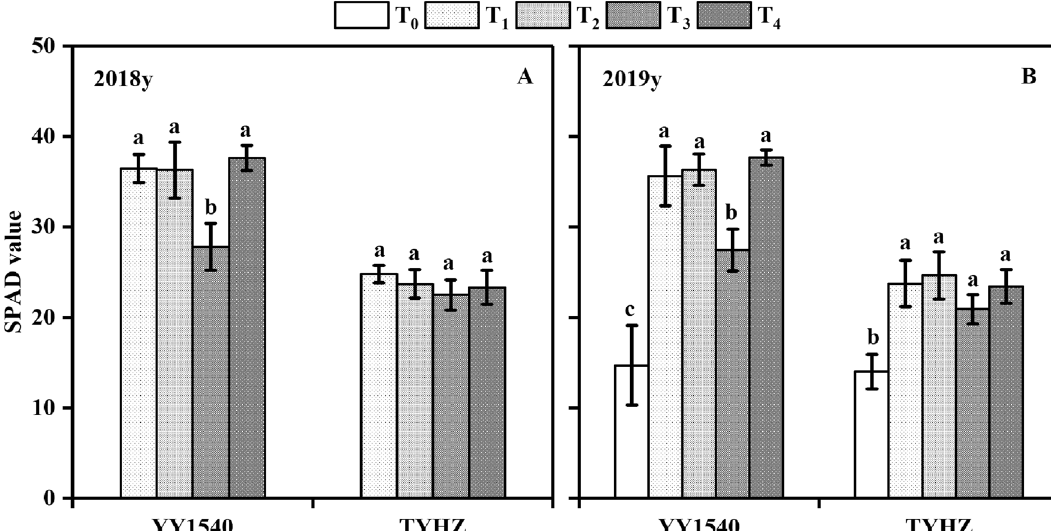
Figure 4. SAPD value at maturing stage of indica – japonica hybrid rice (‘Yongyou1540 ′ , YY1540) and indica hybrid rice (‘Tianyouhuazhan’, TYHZ) under four nitrogen fertilization treatments. ( A ) 2018; ( B ) 2019. Bars with different lower-case are significantly different at the 0.05 probability level among treatments. T 0 no-nitrogen application control, T 1 traditional nitrogen application, T 2 single-dose controlled-release nitrogen application, T 3 70% controlled-release nitrogen as side-deep fertilization with machine transplanting and 30% as topdressing applied at the tillering stage, T 4 70% controlled-release nitrogen as side-deep fertilization with machine transplanting and 30% as topdressing applied at the panicle initiation